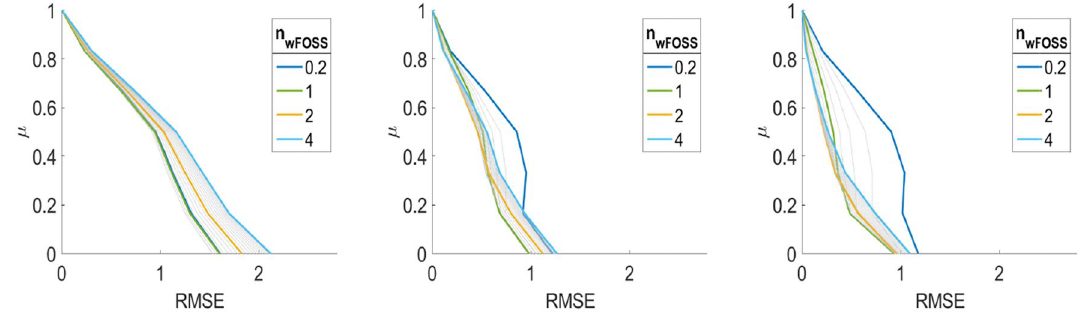
Fig. 13 Camelback function: Average RMSE over the 𝛼 -cuts of the result space for the RBF model with 100 underlying FOSS sampling plans with 4 (left), 9 (center), and 16 (right) sampling